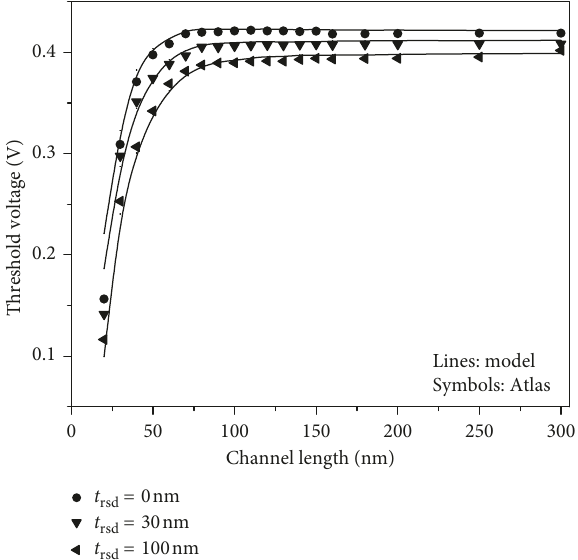
Figure 6: DIBL for the different ratios of control gate and screen gates of the TMG device.